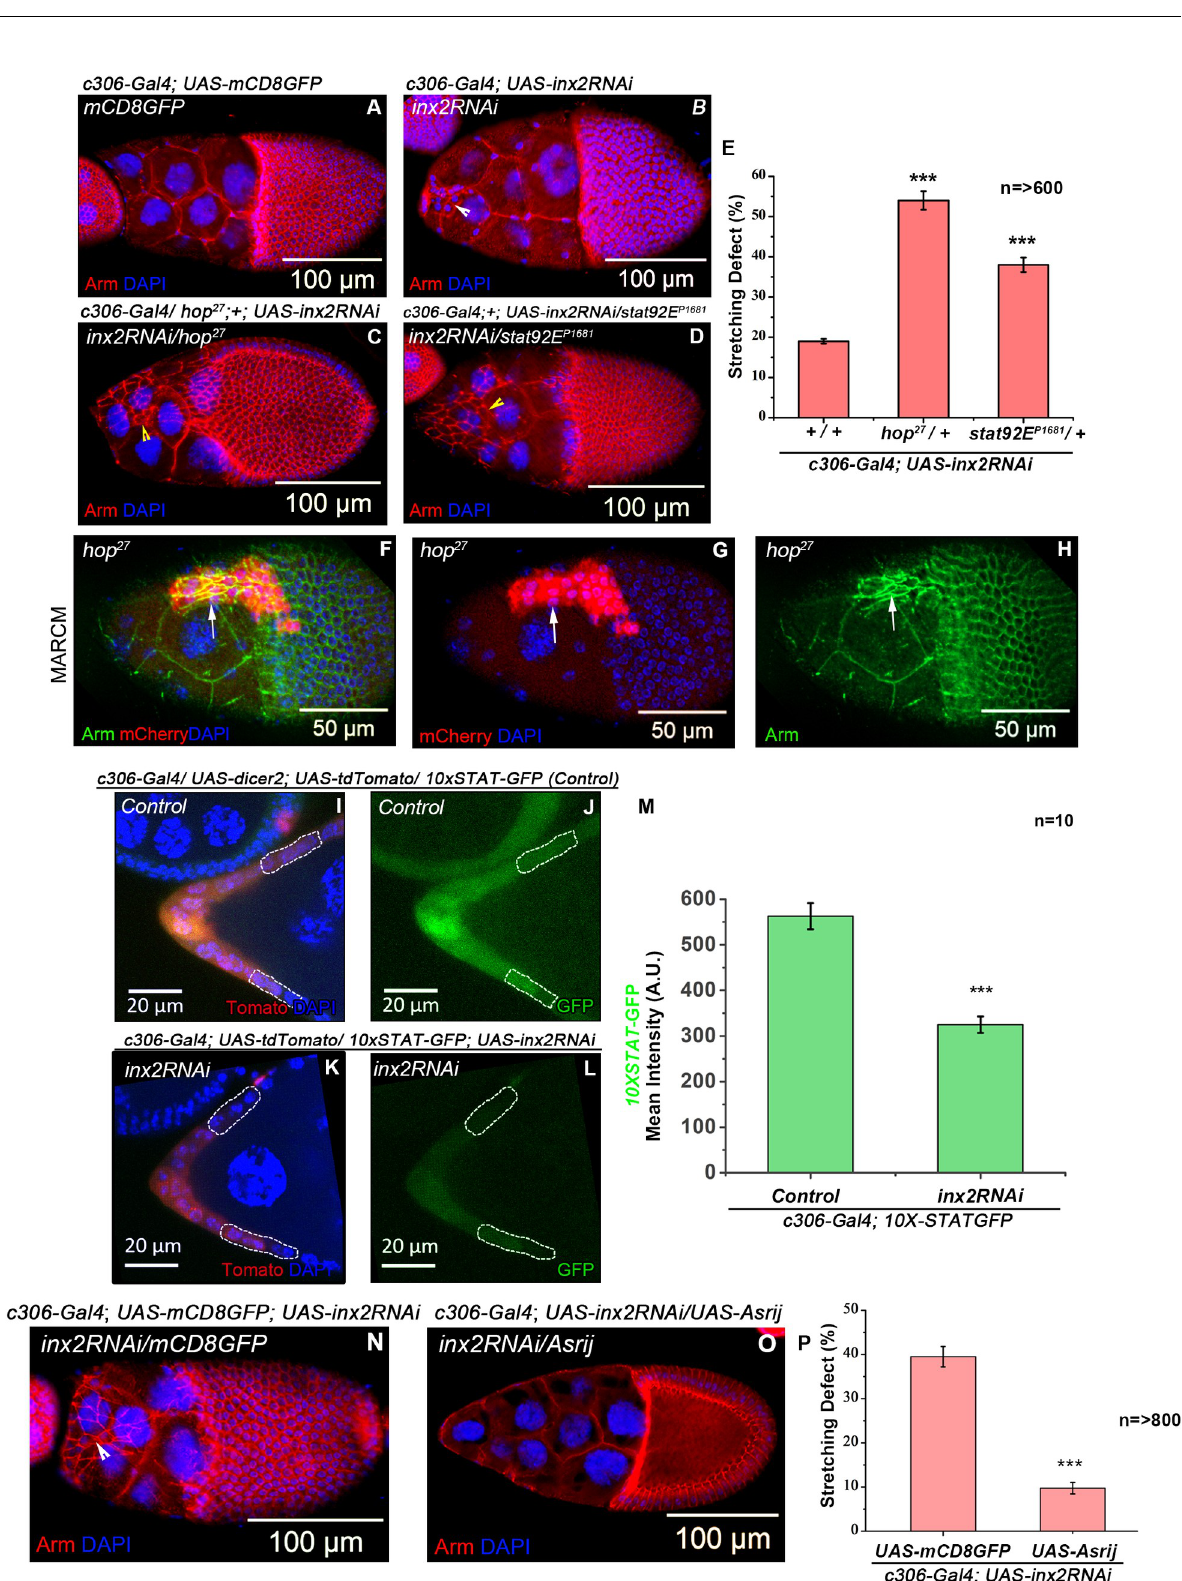
Fig 3. Inx2 functions through JAK-STAT pathway to modulate the shape change in the AFCs. (A-D) Stage 10 egg chambers of indicated genotypes stained with anti-Armadillo in Red and DAPI in blue. Arrowheads mark the unstretched follicle cells. (E) Quantification of the